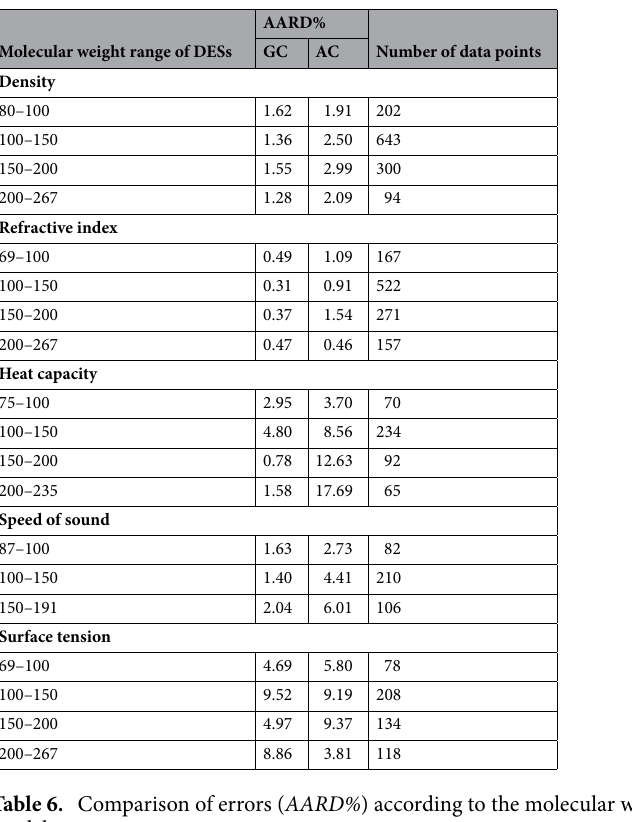
Table 6. Comparison of errors ( AARD% ) according to the molecular weights of the DESs for the GC and AC